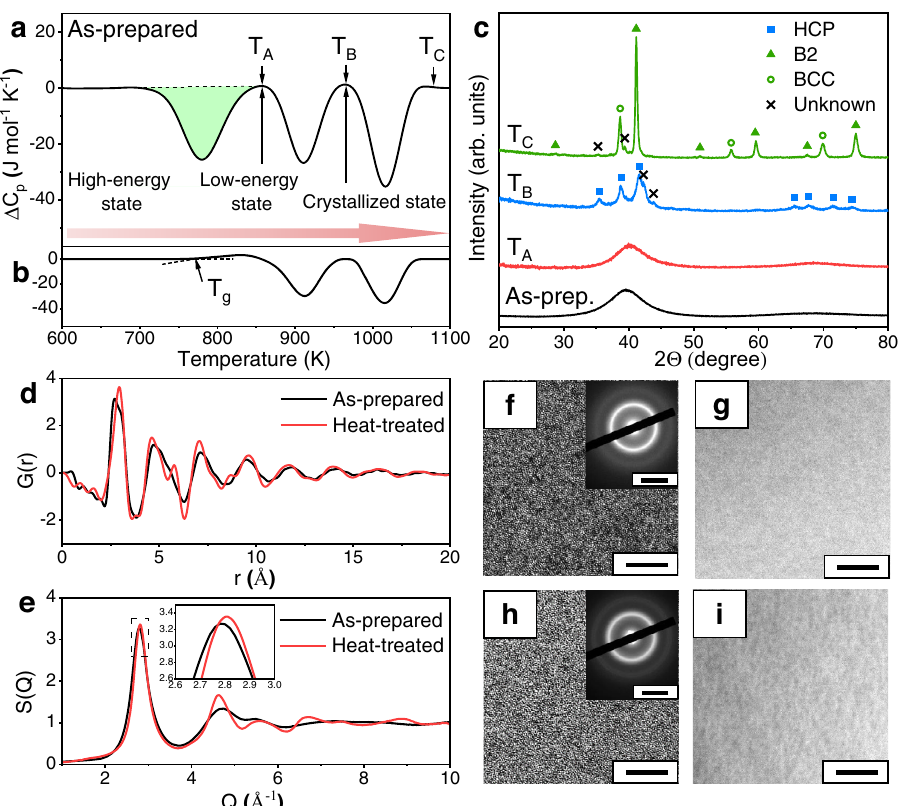
Fig. 1 Speci fi c heat ( Δ C P ), X-ray diffraction, synchrotron X-ray diffraction, HRTEM, SAED, and HAADF analyses of the as-prepared and heat-treated NbNiZrTiCo HEMGs. a DSC curve of the as-prepared sample. The structures of the alloy are denoted and the anomalous exothermic peak ( fi lled in green) shows heat release comparable to that of crystallization. During heating, the HEMG undergoes phase transitions from a high-energy glass state to a low- energy glass state and further to a crystallized state (red arrow). b DSC curve of the heat-treated sample. The fi rst exothermic peak in the as-prepared sample disappears. To highlight the phase transitions, the curve of the crystallized HEMG (samples heated to 1173 K) was subtracted in a and b . c XRD results of the as-prepared and heat-treated samples. The T A , T B , and T C denote the heat treatment temperatures. As-prep.: As-prepared sample. d Synchrotron X-ray diffraction results of the as-prepared and heat-treated samples in real space measured at room temperature. e Synchrotron X-ray diffraction results of the as-prepared and heat-treated samples in Q -space measured at room temperature. Inset: enlarged fi rst diffraction peak in the dotted box. f HRTEM (scale bar: 5 nm) and SAED (inset, scale bar: 5 nm − 1 ) result of the as-prepared sample. g HAADF (scale bar: 20 nm) result of the